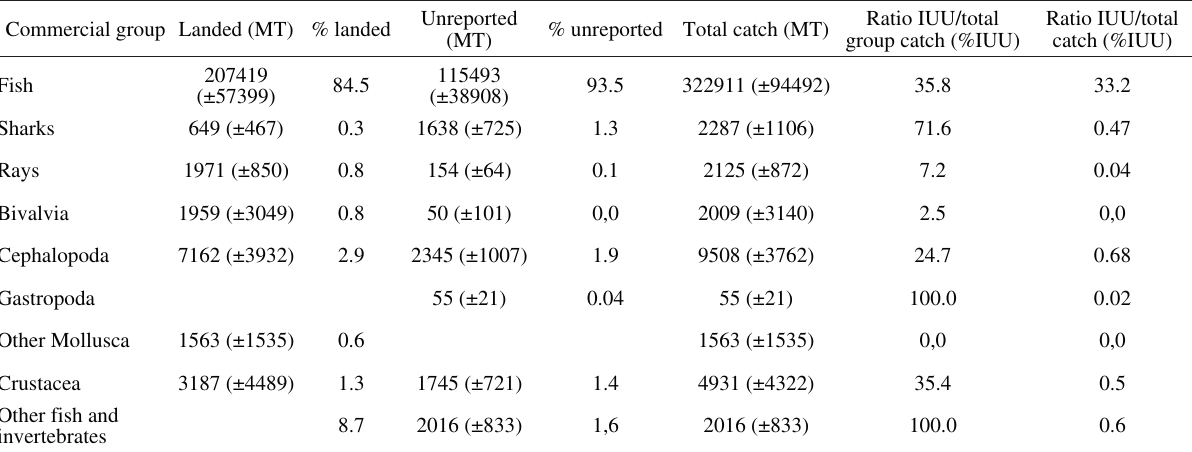
Table 2. – Average catches in weight (t±SD) of landed and unreported (discarded) catches per commercial groups, with respective relative contribution (%) of each group to total group catch and overall catch, for the period 1938-2009. Commercial group Landed (MT) %